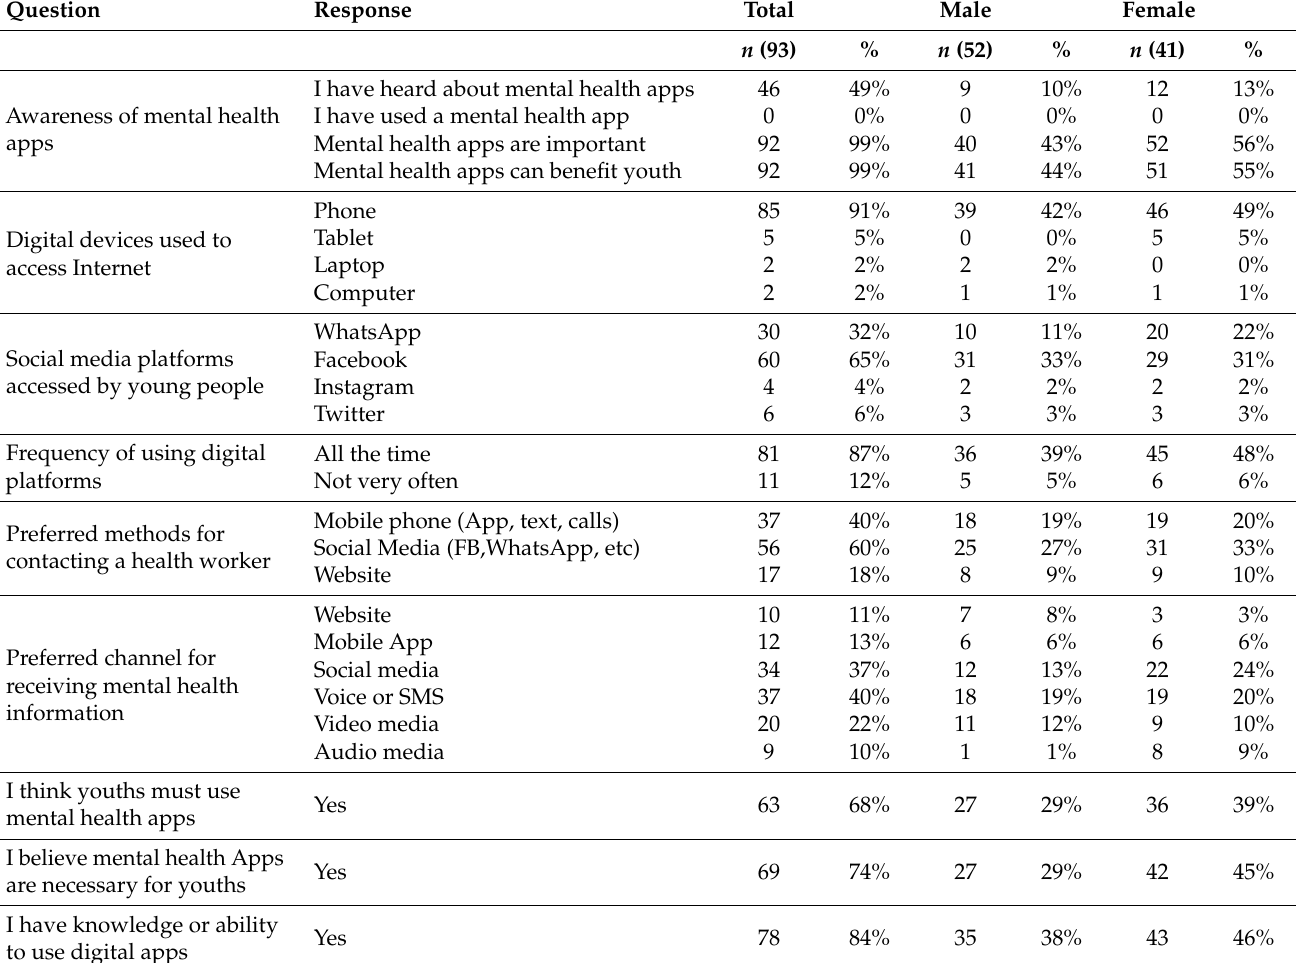
Table 5. Showing the outcomes to questions relating to access to digital platforms and